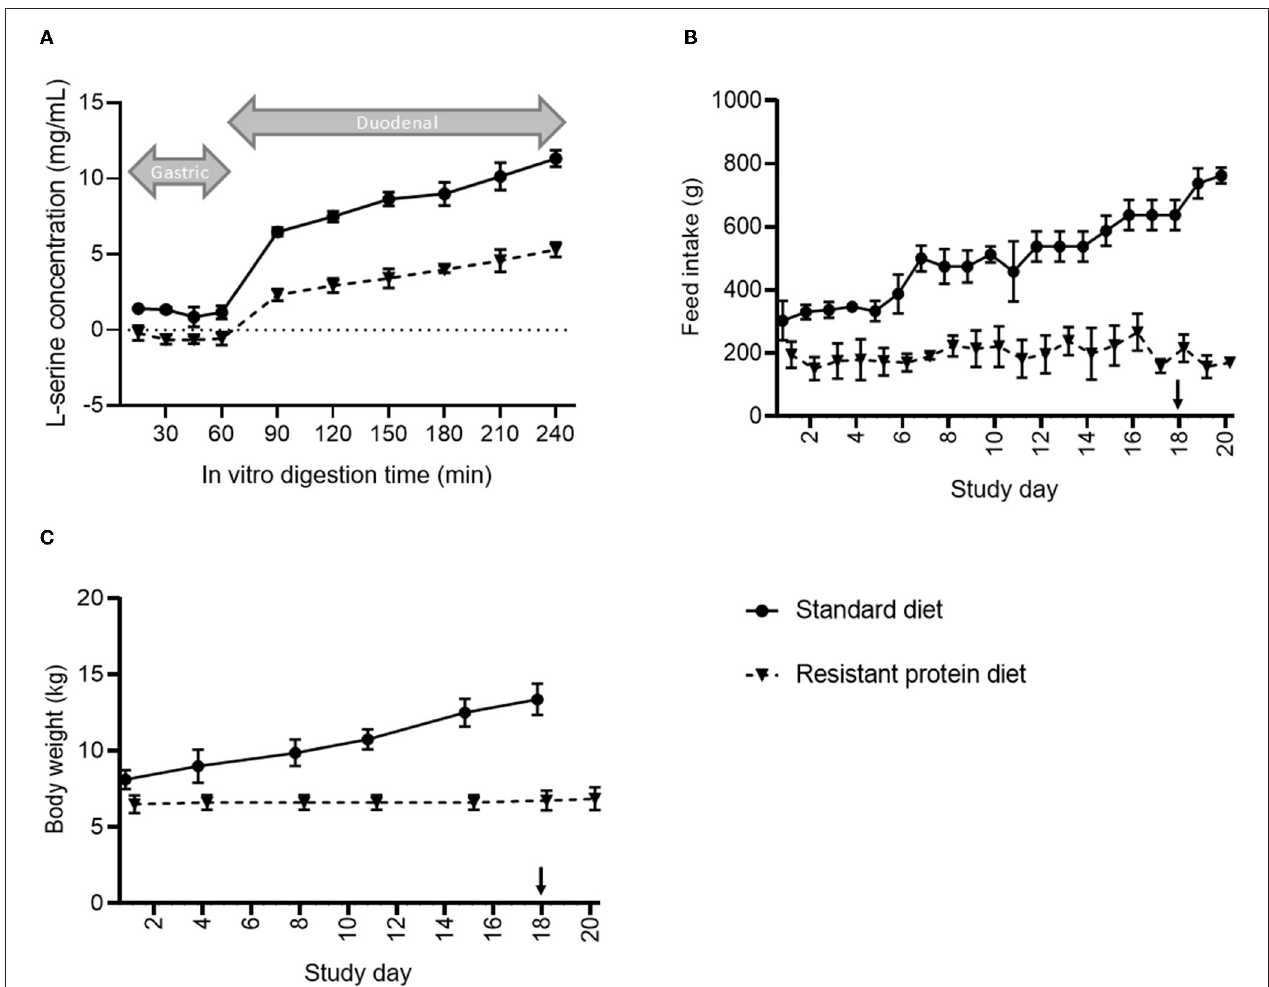
FIGURE 2 | Comparison of (A) in vitro digestibility, (B) average daily feed consumption, and (C) changes in the body mass of pigs fed standard vs. resistant protein diets, where ‘ ↓ ’ indicates where the resistant protein diet was supplemented with 25% of the standard diet. Results represent the mean and SD of data for n = 4 pigs per group. From day 1 onwards, feed intake and body weight were significantly different between groups ( p <